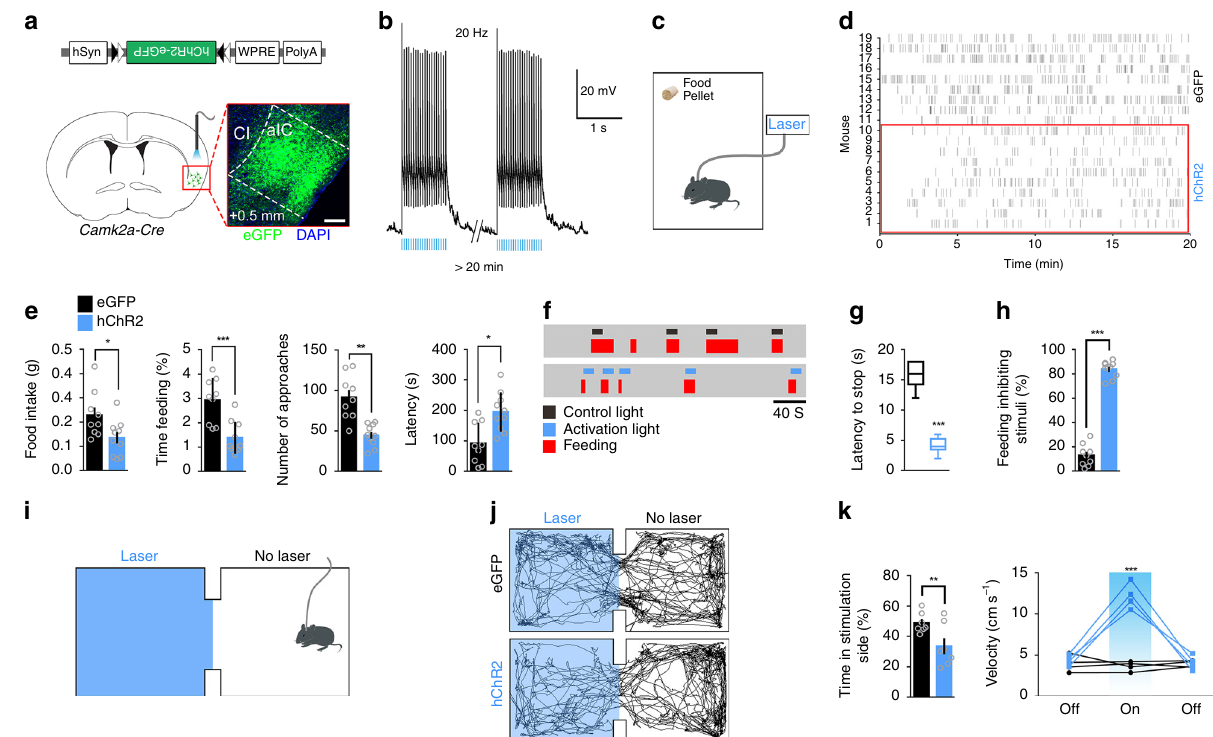
Fig. 2 Activation of the right aIC CamKII neurons suppresses food intake. Diagrams illustrating the injected virus (upper) and injection site in the caudal segment of the right aIC (lower). The inserted image shows the expression of hChR2 (H134R)-eGFP in the right aIC. WPRE woodchuck hepatitis virus post- transcriptional regulatory element; pA poly a ; Cl claustrum. Scale bar, 500 μ m. b Brain slice whole-cell patch-clamp recording traces showing action potentials triggered in the aIC CamKII neurons expressing hChR2 by 20 Hz, 10 ms, 473 nm laser pulses. c Schema to assess food intake for optogenetics. d Raster plot of food approaches in 24-h fasted mice expressing hChR2(H134R)-eGFP in the right aIC. e Total food consumption, percentage of time spent feeding, number of approaches to food and latency of the fi rst approach to food were measured during a 20-min test ( n = 9 for eGFP mice, n = 10 for hChR2 mice, Two-tailed unpaired t test). f Raster plots showing feeding processes by one 24-h fasted mouse in its home cage. Activation light (473 nm) or control light (589 nm) was triggered after feeding began. g Latency to stop feeding in response to light activation (473 nm), 30 trails from fi ve animals ( n = 5 mice per group, Two-tailed unpaired t test). h The percentage of light stimuli (473 nm) that inhibits feeding ( n = 9 for eGFP mice, n = 10 for hChR2 mice, Two-tailed unpaired t test). i Schema depicting the real-time place performance (RTPP) paradigm. j Representative locomotor trace of a mouse with the caudal segment of the right aIC CamKII expressing eGFP or hChR2 that received the 20-Hz photostimulation in the laser compartment. k Percentage of time spent (left) and locomotor activity (right) in laser or no laser side ( n = 9 for eGFP mice; n = 10 for hChR2 mice, Two-tailed unpaired t test). * P <